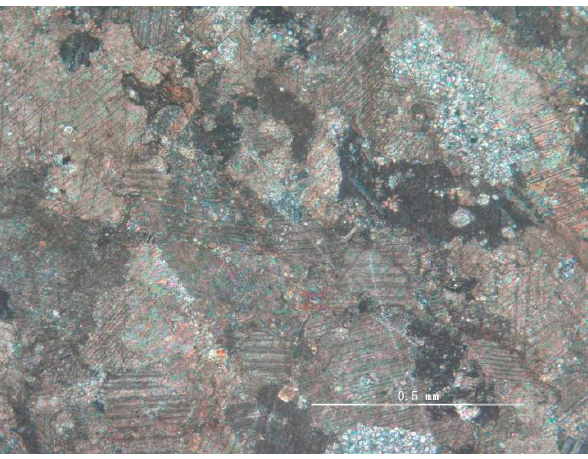
Figure 3. Thin sections of carbonate rocks observed under optical microscopy.